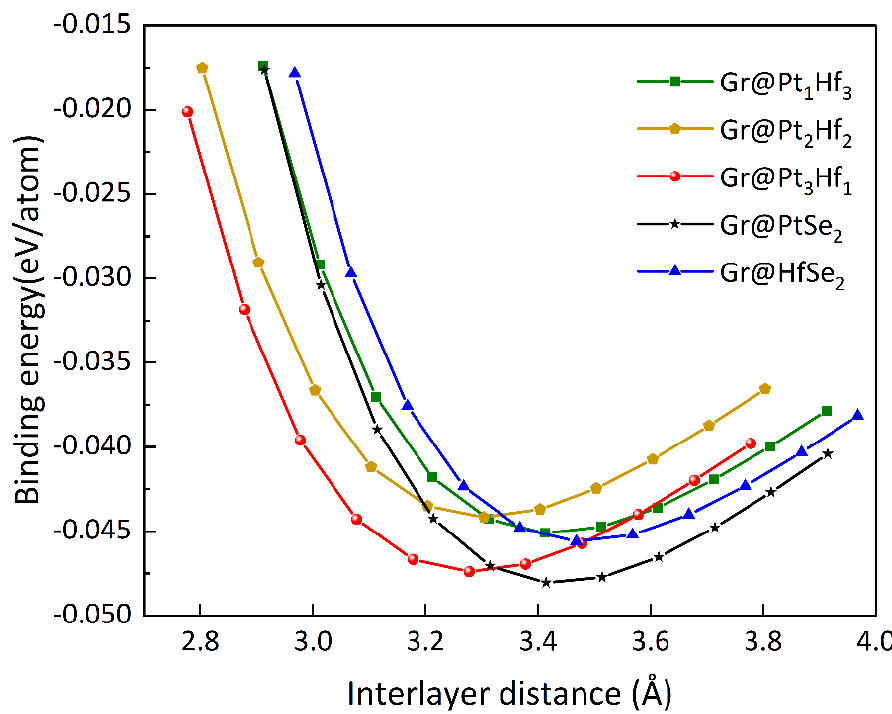
Figure 2. The binding energy of graphene per C atom for Gr@Pt n Hf 4 − n , as a function of the interlayer distance between graphene and Pt n Hf 4 − n .